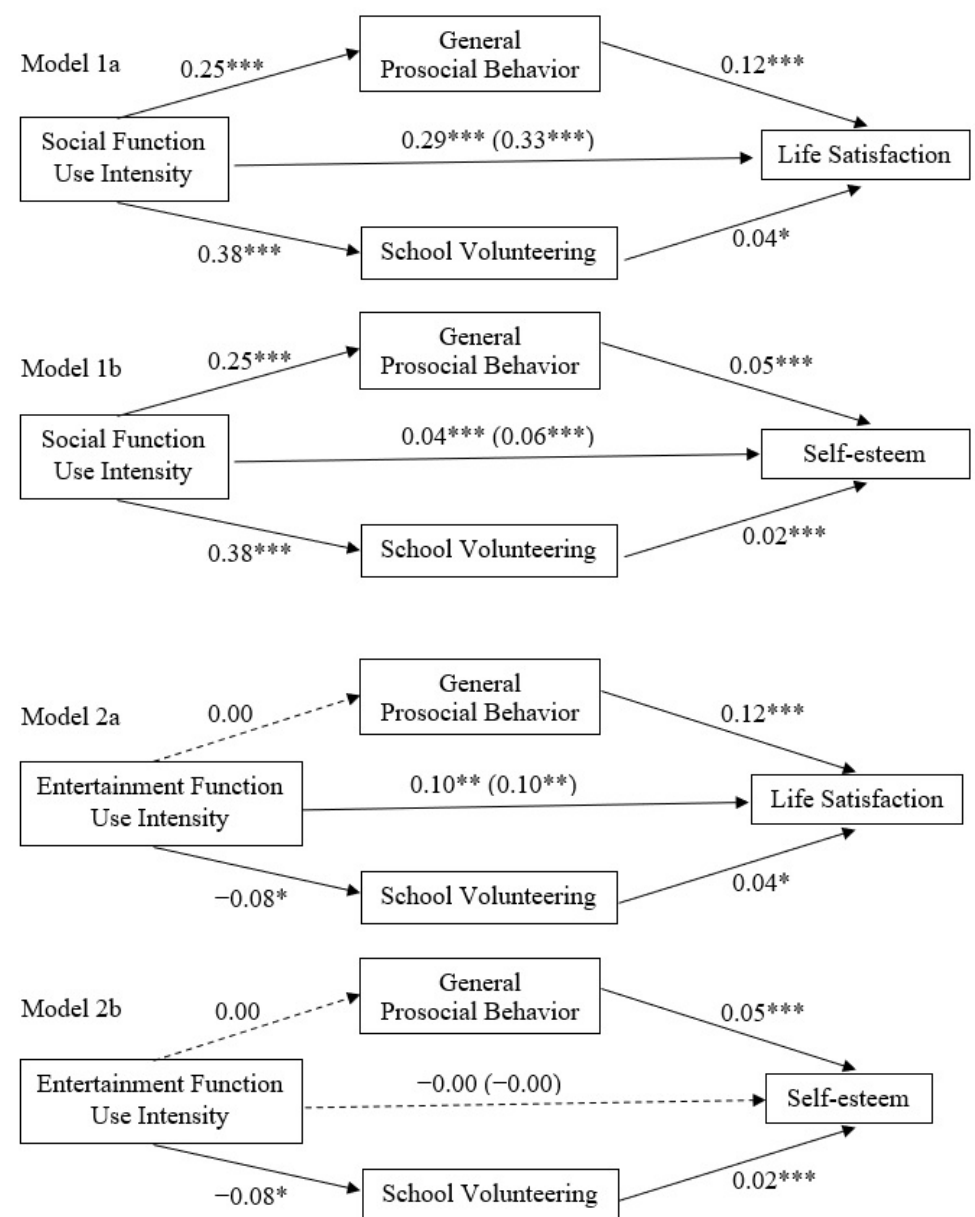
Figure 2. Unstandardized coefficients of the mediation model (controlling for other function use intensity, sex, age, smartphone use frequency, and school regions) depict prosocial behavior as a mediator between SNS function use and well-being. Note. N = 3452. Coefficients in parentheses illustrate the total effect without the mediators. EFUI was controlled for in Models 1a and 1b while SFUI was controlled for in Models 2a and 2b. Dashed lines represent a nonsignificant relationship ( p > 0.05). * p < 0.05. ** p < 0.01. *** p <